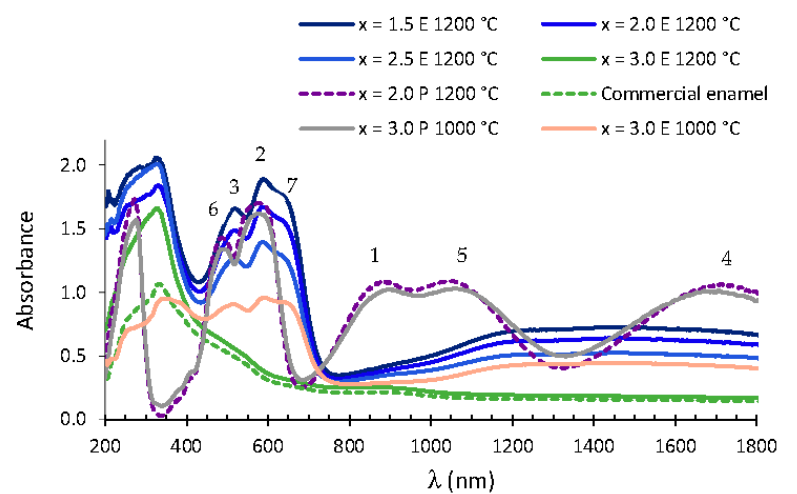
Figure 8. UV–vis–NIR spectra of 3% Mg x Co 3 − x P 2 O 8 (0.0 ≤ x ≤ 3.0) compositions fired at 1200 °C and the commercial enamel and composition fired at 1000 °C with x = 3.0. E: enamelled sample. P = powdered sample. Co(II) CN= 6: (1) 4 T 1 → 4 T 2 , (2) 4 T 1 → 4 A 2 , (3) 4 T 1 → 4 T 1 (P). Co(II) CN = 5: 4